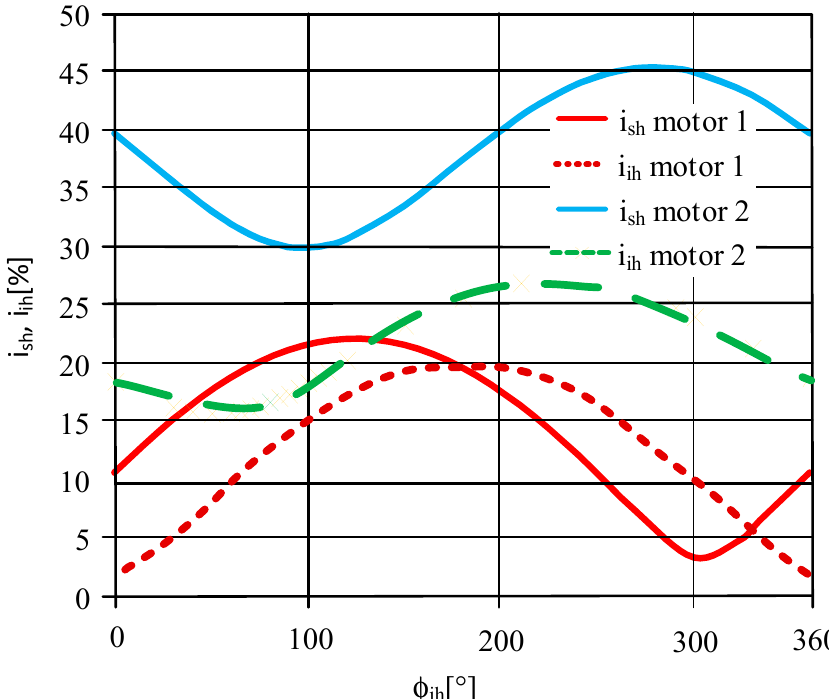
Figure 9. Current subharmonics and interharmonics versus the angle φ ih for φ sh = 0 ◦ , the load with a negligible moment of inertia and voltage fluctuation of the resonant frequency equal to f m = 7 Hz and f m = 30 Hz for motor1, motor2, respectively.